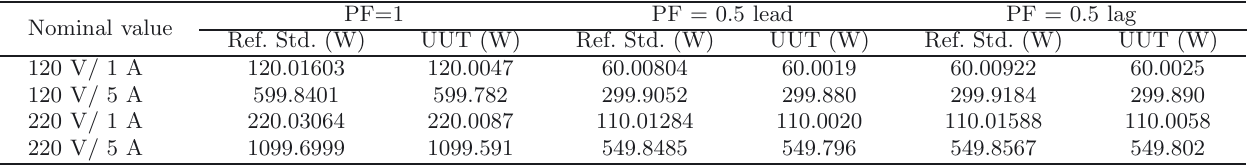
Table 3. Calibration results of the test power meter (MSB